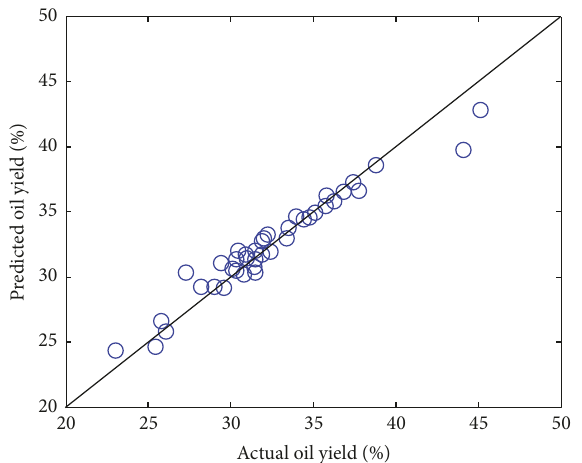
Figure 3: Correlation plot between the actual and predicted TAEP sesame oil yield by D2-LS-SVM.